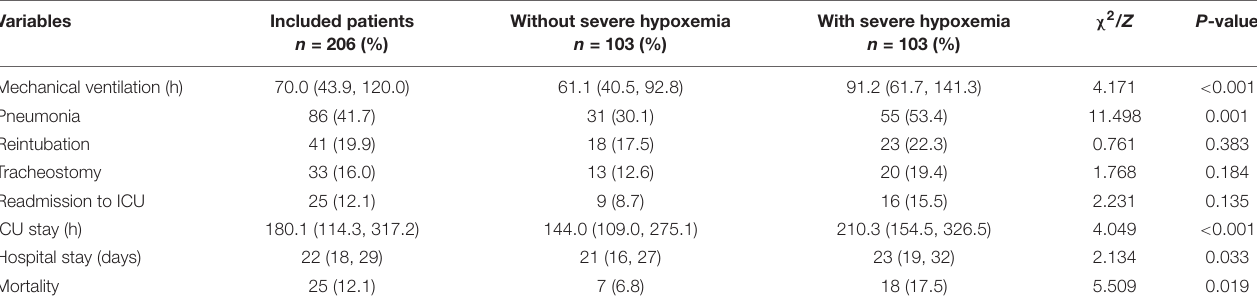
TABLE 5 | Clinical outcomes in patients with and without severe hypoxemia following AADS after propensity score matching.